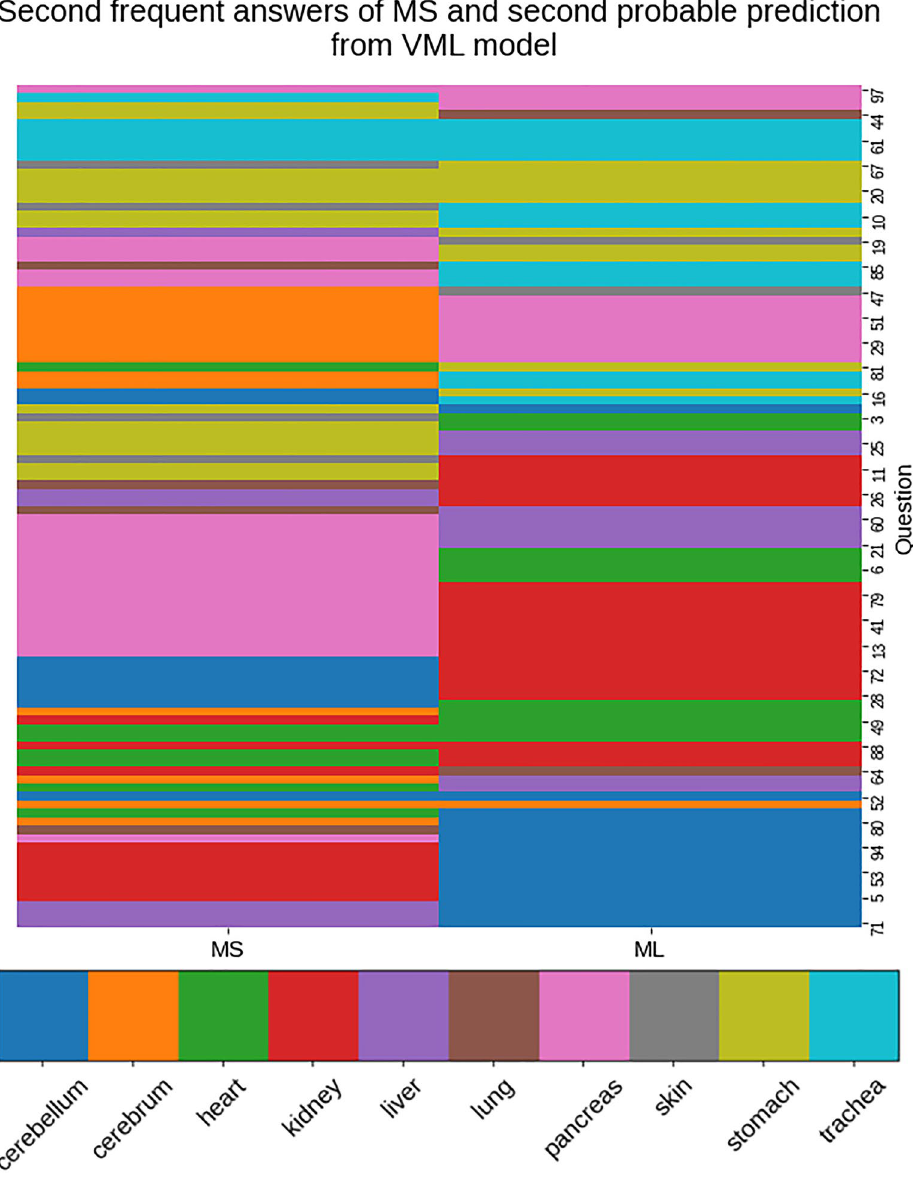
Figure 11. The second commonest answer of the medical students, and the prediction from VML model with second highest probability—matched only in 15 images of the quiz questionnaire ( n = 100); in 14 of these images, the first prediction also matched (Figure generated by Matplotlib python library, version 3.3.4, https:// matpl otlib.